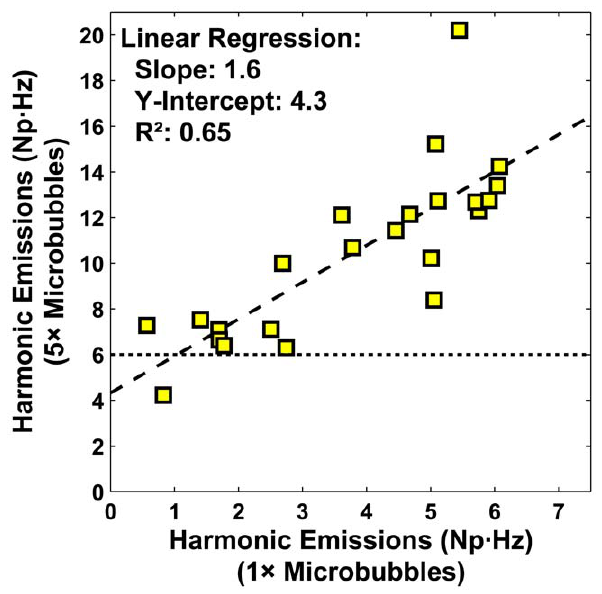
Figure 9. Increase in harmonic emissions strength with in- creased microbubble dose. Individual subsonications with low harmonic emissions signals were sonicated again with five times the microbubble dose. Signals recorded during the second sonication increased substantially; all but one increased to a level above 6 Np ? Hz, a level where MRI-evident BBB disruption is expected based on results in Fig. 5. The two measurements were correlated (R 2 : 0.65). The measured slope indicates that the strength of the harmonic emissions is proportional to the number of oscillating microbubbles, since the signals were log-transformed (Eq. 3, log(5)=1.6). A non-zero Y-intercept suggests that there may have been low-level harmonic emissions during the first sonication that were below our detection